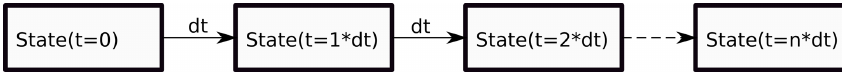
Figure 5. Time advance for a step-by-step simulation.